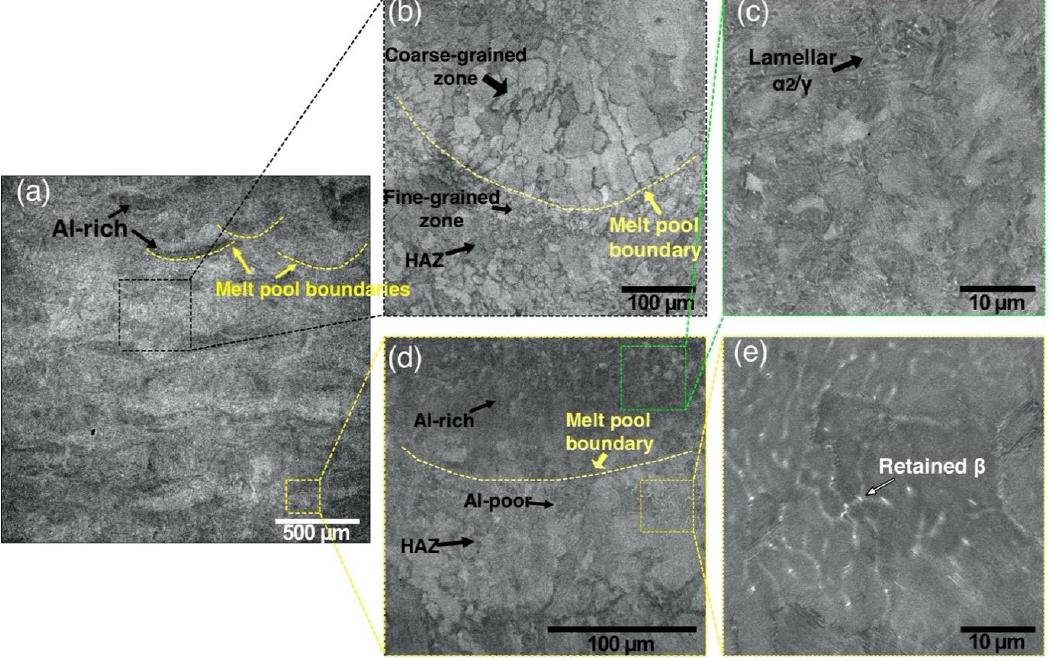
Figure 11. BSE-SEM images showing the microstructure variation in the “Large spot” sample produced from GA powder: ( a ) a general view, ( b ) a magnified area showing a melt pool section, ( c ) Al-rich area, ( d ) a melt pool boundary, ( e ) Al-poor area